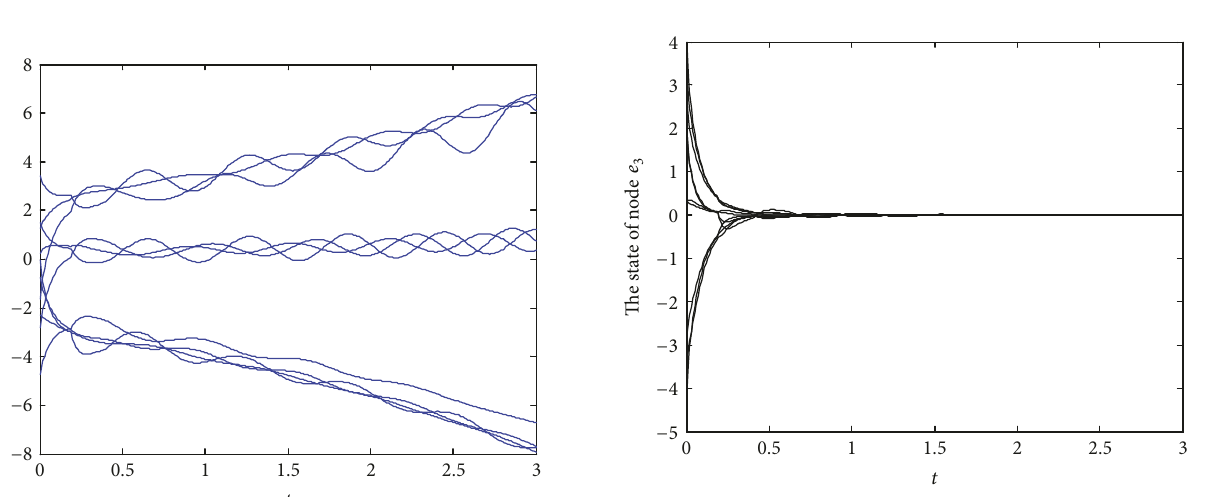
Figure 6: Synchronization error 𝑒 𝑖3 that does not satisfy the conditions.